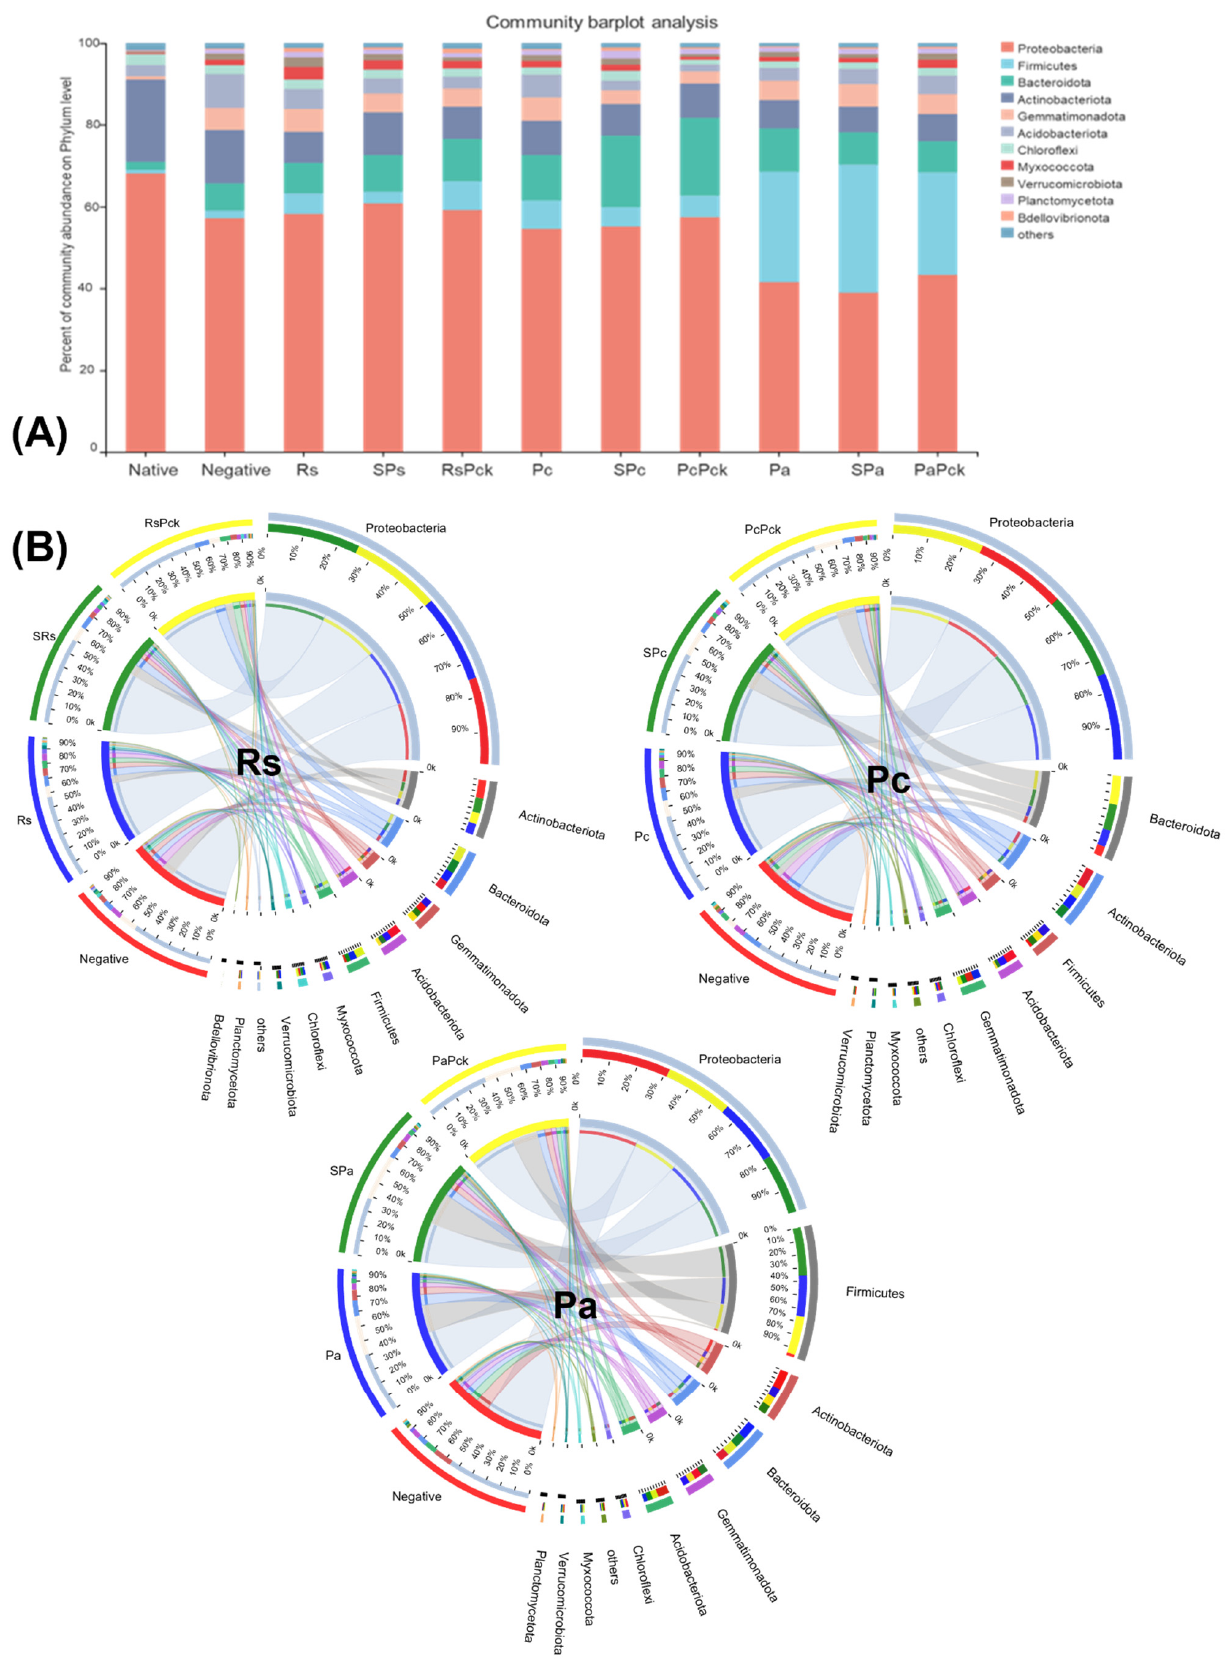
Figure 3. The microbial composition of the surveyed microbiota at phyla level, presented as ( A ) barplot and ( B ) comparative circus plot for each of the three phage therapy treatments (Rs, Pc, and Pa).